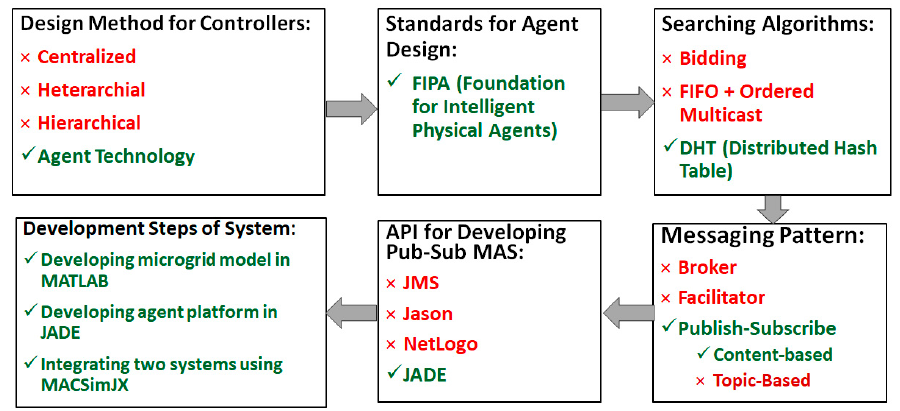
Figure 17. Technologies used in the development of the coordinated control system.